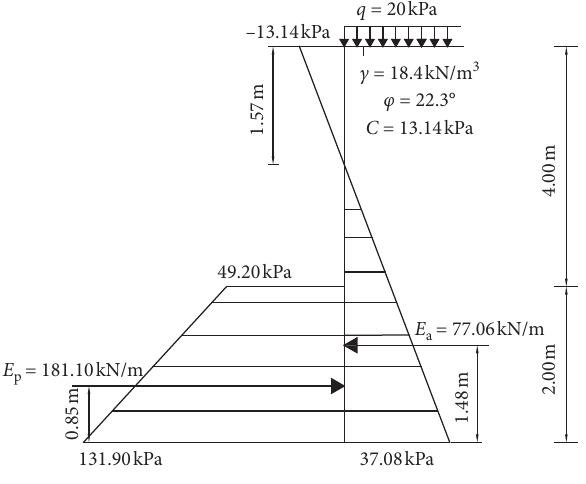
Figure 1: Distribution of earth pressure